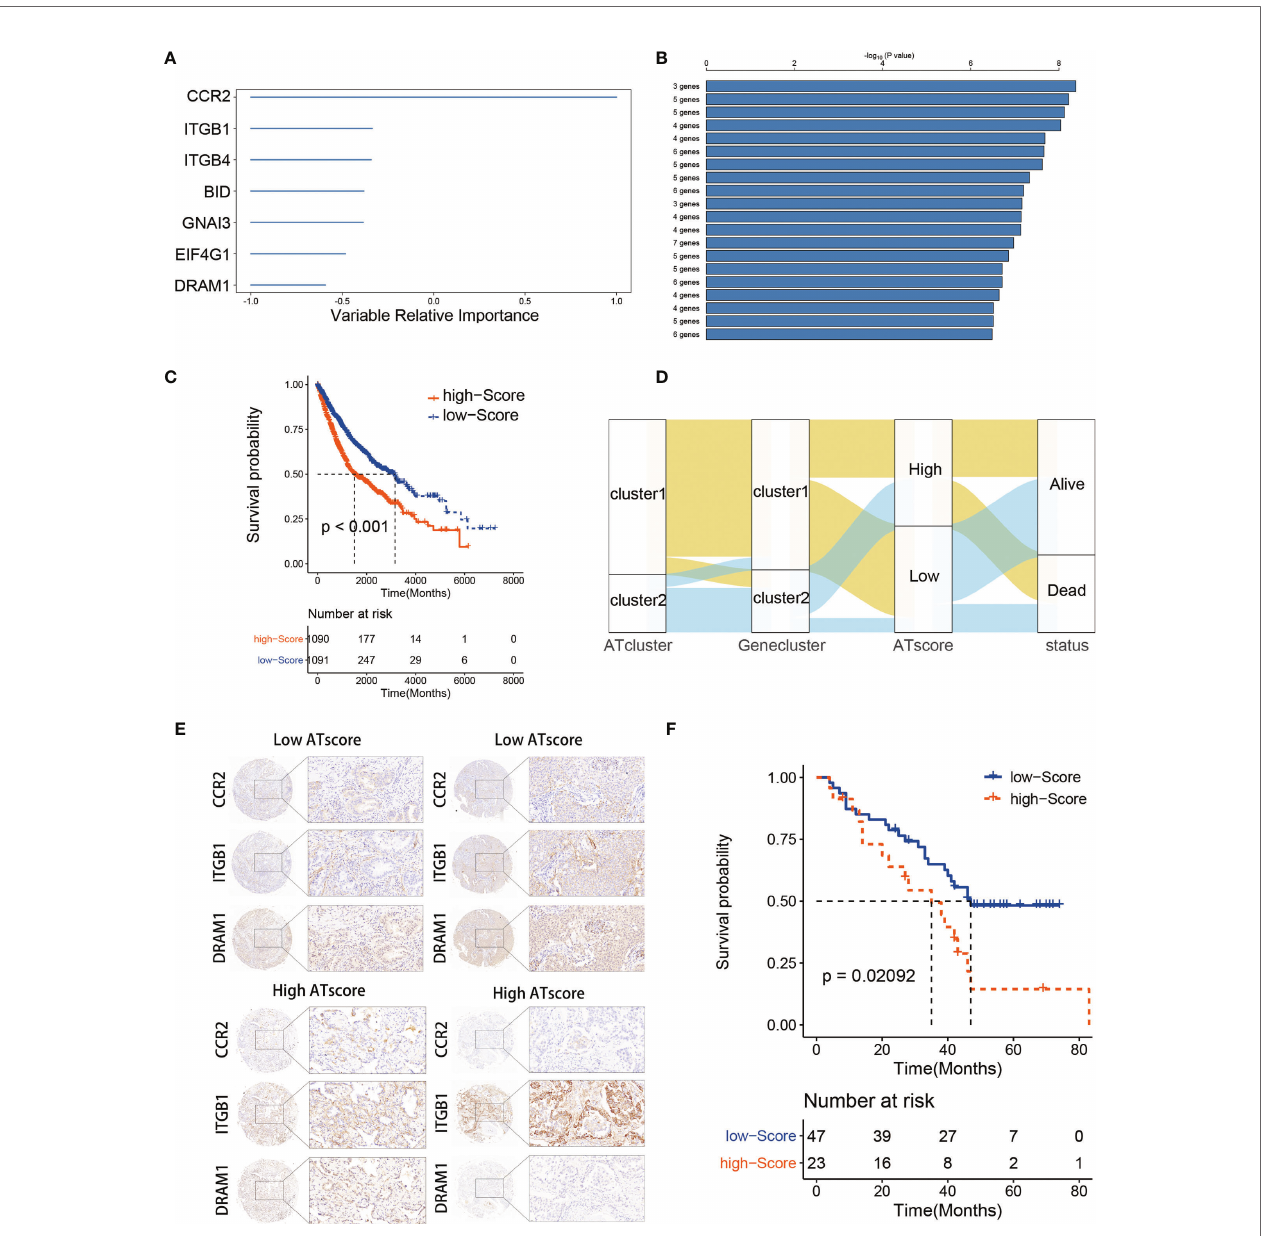
FIGURE 4 | The construction of ATscore and the validation of its prognostic predictive value. The relative importance of the 20 autophagy regulators was calculated by random survival forest analysis, and the 7 most critical ones were showed (A) . The log-rank analyses showed that ATscore constructed by 3 genes predicted LUAD patients ’ prognosis with a lowest P value (B) . LUAD patients with higher ATscore had noticeable worse overall survival in meta-cohort (C) . Sankey plot illustrating the interconnection among the ATclusters, Geneclusters, ATscores, and patient survival (D) . The representative IHC pictures of biopsies from independent cohort were showen (E) , and the prognostic predictive value of the ATscore was validated in independent cohort (F)